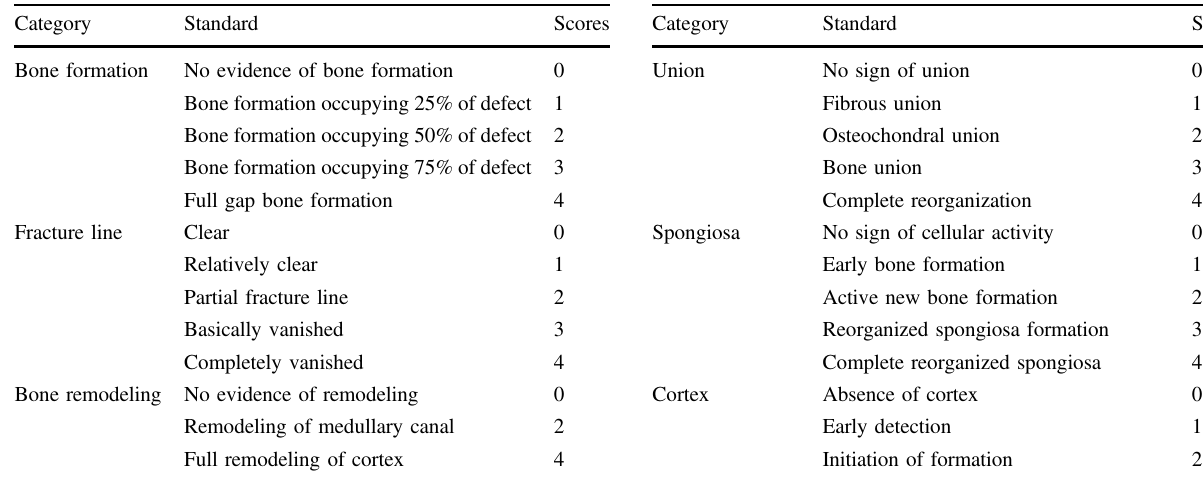
Table 2 Lane – sandhu histological score